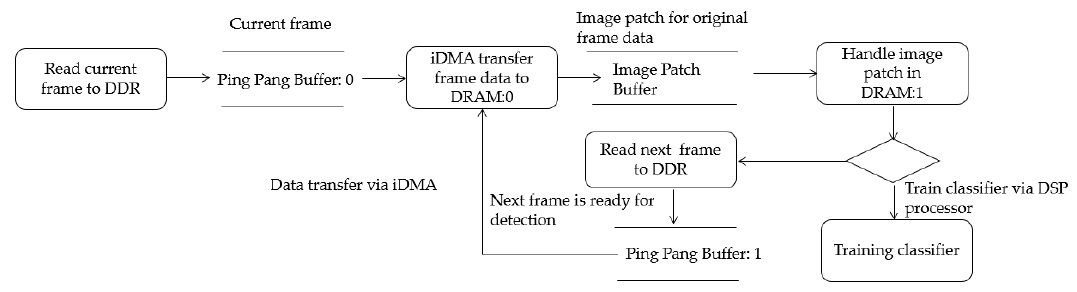
Figure 6. Processing sequence of frame data.